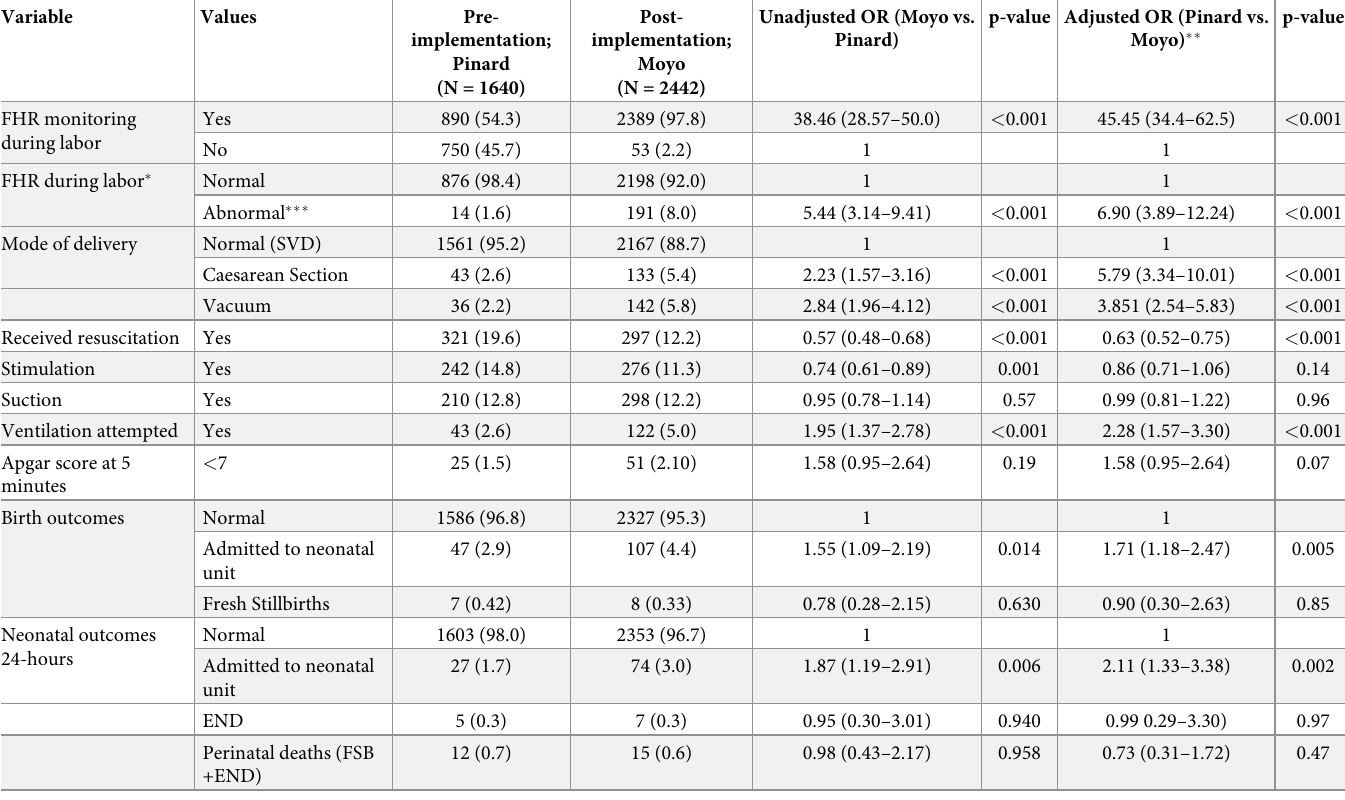
Table 2. Proportions, unadjusted and adjusted comparison of FHR documentation practices and outcomes post vs. pre-implementation of strap-on automatic Doppler